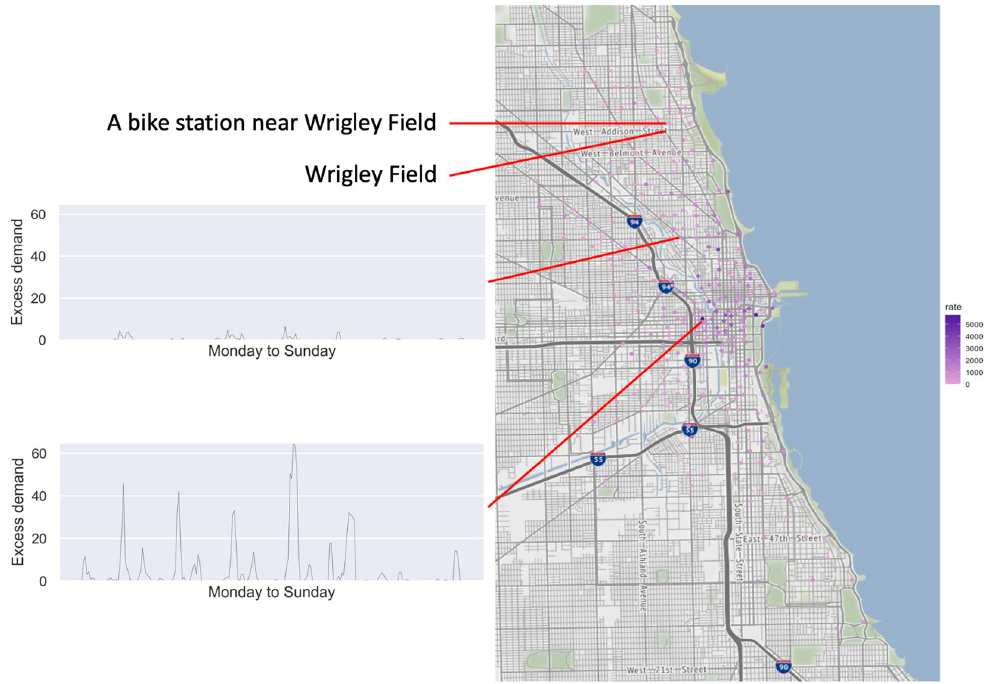
Fig 7. Cumulative bike excess demand rate for different stations. Reprinted from [40] under a CC BY license, with permission from OpenStreetMap, original copyright 2021.